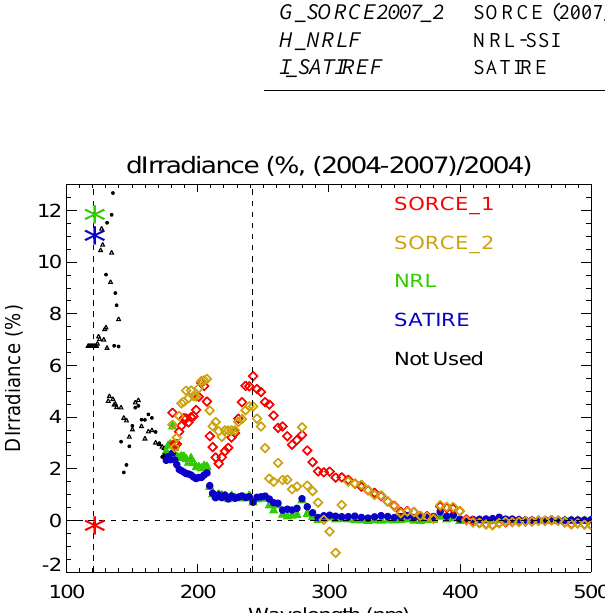
Fig. 1. Relative percentage differences in solar irradiance be- tween 2004 and 2007 ((2004–2007)/2004) for the SORCE_1 and SORCE_2 (red and orange diamonds), NRL-SSI (green triangles) and SATIRE (blue circles) solar flux data sets. The threshold wave- length (242nm) controlling O 3 production and destruction is indi- cated with a vertical dashed line. Solar flux changes in the Lyman- α line are indicated with stars ( ∗ ) on a vertical dashed line at 121.6nm. Note that runs with SORCE fluxes do not include Lyman- α changes. Black symbols indicate variations in Schumann–Runge continuum in NRL-SSI and SATIRE data sets but are not included in any of the model